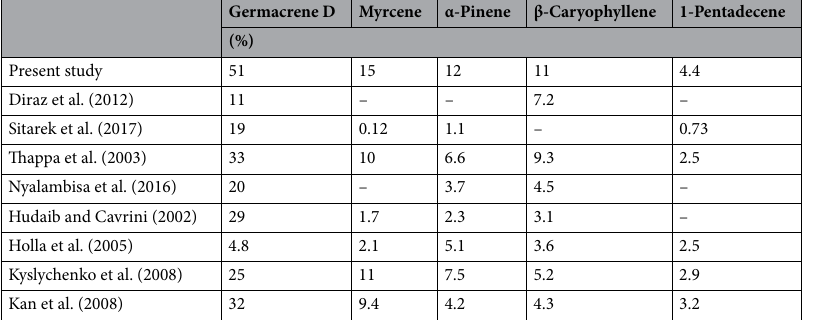
Table 5. Maximum percentage of major essential oil compositions of E.purpurea reported in various previous studies.